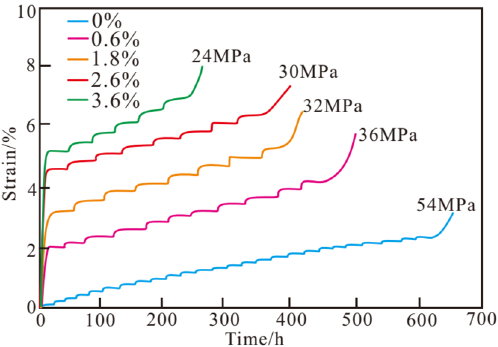
Figure 6. Creep curves of mud shale with different moisture content under step